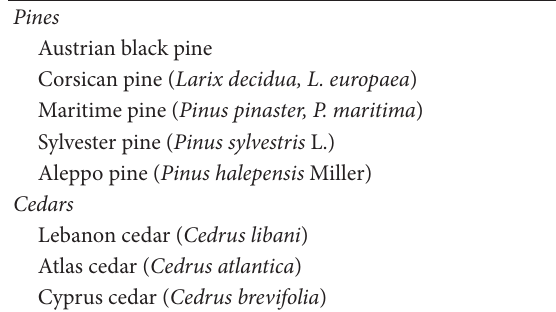
Table 3: Pines and cedars most commonly infested by Thaume- topoea pityocampa Schiff. Pines